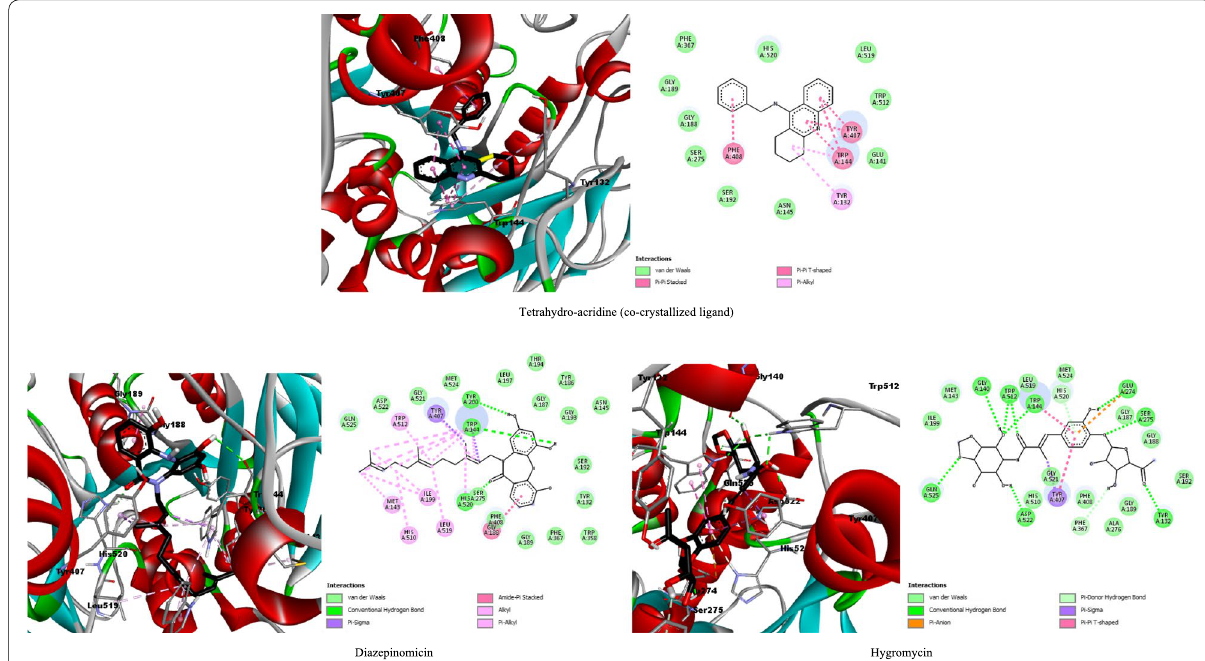
Fig. 3 3D and 2D illustrations showing the interactions between the co-crystallized and the top two ligands and the modeled A. pisum ’s